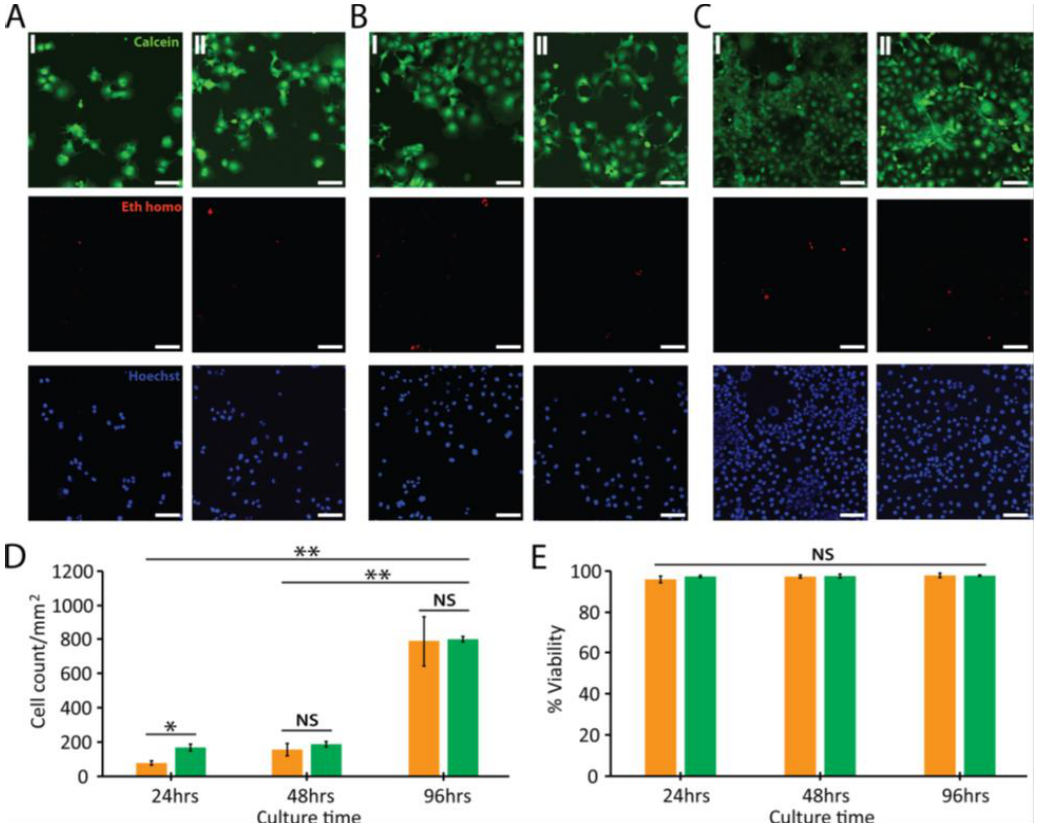
Figure 7. Live−dead assay for Cos -7 cells cultivated on ( I ) glass and ( II ) graphene for ( A ) 24 h, ( B ) 48 h, and ( C ) 96 h. Green, red, and blue denote live cells, dead cells, and cell nuclei, respectively. Scale bars: 100 μm. ( D ) cell number and ( E ) % viability of Cos-7 cells cultivated on the glass (orange) and graphene (green) for 24, 48, and 96 h, respectively. * and ** denote p < 0.05 and p < 0.005, respectively. NS implies no statistically significant difference. Reproduced from [96] with permission of the American Chemical Society.